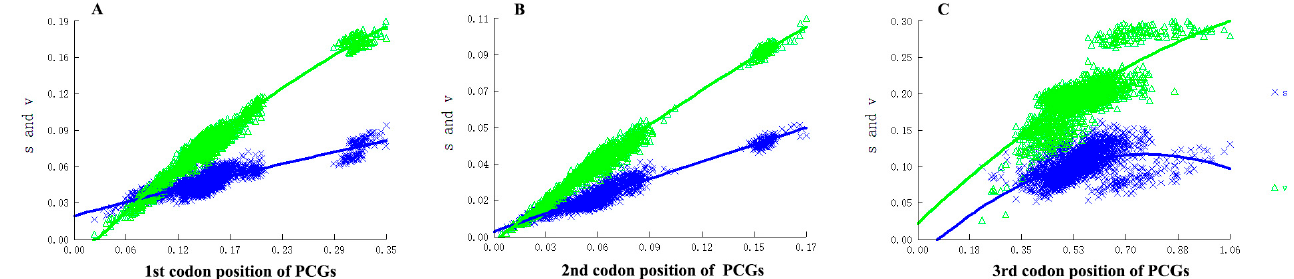
Figure 5. Nucleotide substitution saturation plots of all 13 mitochondrial protein-coding genes. ( A ) The 1st codon positions; ( B ) The 2nd codon positions; ( C ) The 3rd codon positions. Plots in blue and green indicate transition and transversion, respectively.